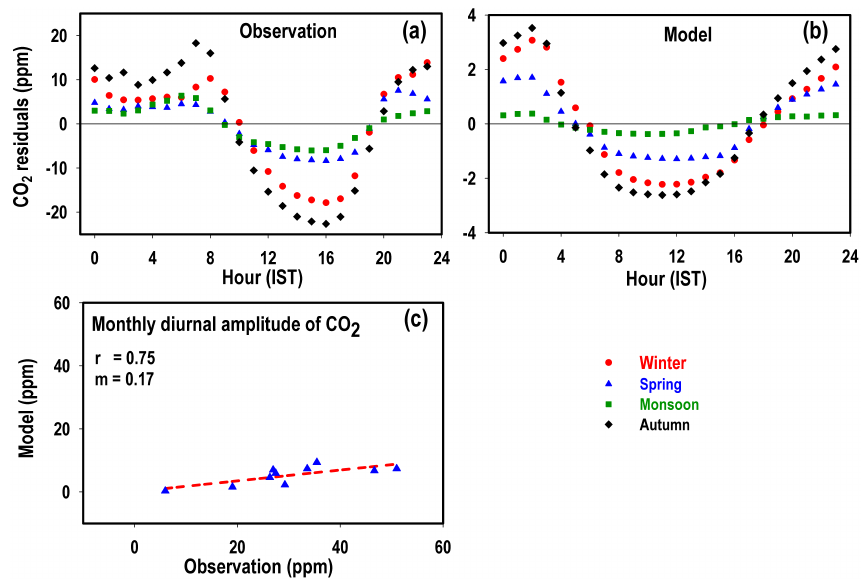
Figure 9. Residual of the diurnal cycle of CO 2 (inppm) for (a) observations and (b) model simulation over Ahmedabad in all four seasons. Please note that the scales of the model and observational diurnal cycles are different. (c) Correlation between observed and the model simulated monthly mean diurnal cycle amplitudes.